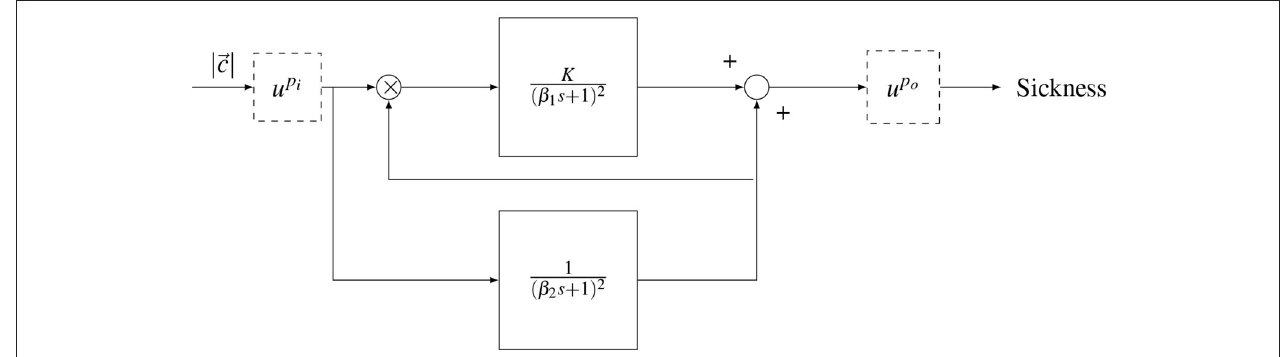
FIGURE 2 | Oman’s model of motion sickness development in time. The rectified conflict signal | c | is fed in to the model. There is a fast (upper) path and a slow (lower) path. The slow path multiplies with the conflict as the gain of the fast path. Both systems are second order with repeated poles. The fast and slow path are then summed. The model has either an input power scaling or an output power scaling given by u p i and u p o , respectively.